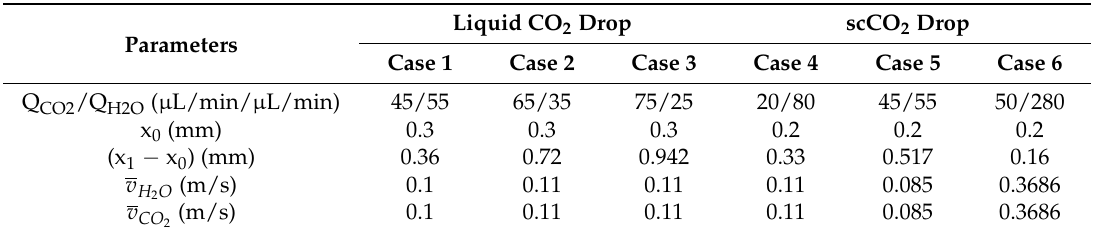
Table 1. Simulation cases for a single flowing liquid CO 2 and scCO 2